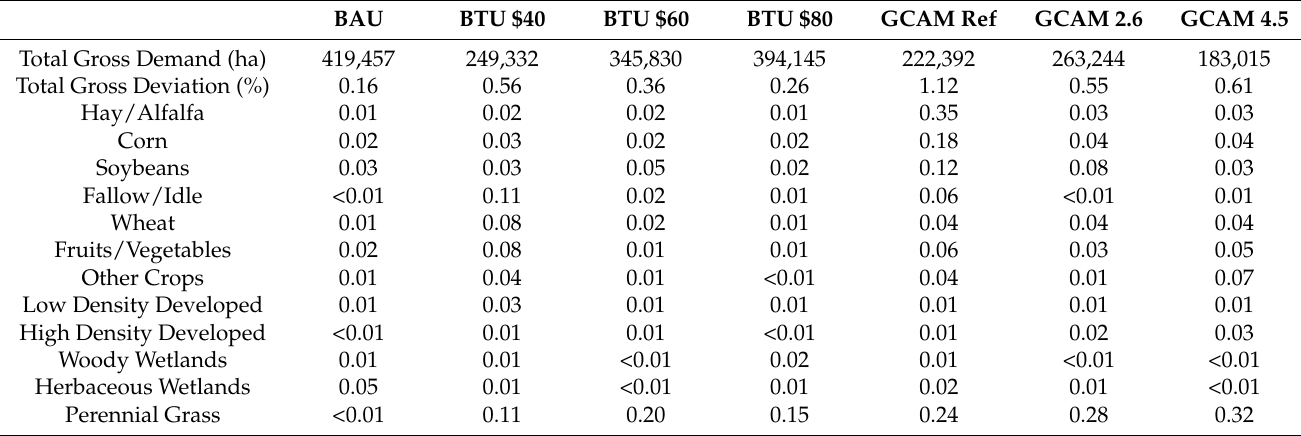
Figure 8. Comparisons of modeled (solid orange) quantities and prescribed demand (dashed black) for all categories and years of historical backcasting. (Note: demand for “flexible” categories is represented by initial (2018) quantities.). Table 4. Gross prescribed change (both positive and negative) and absolute deviation from prescribed change aggregated over all forecast years, separated into categories with explicitly supplied